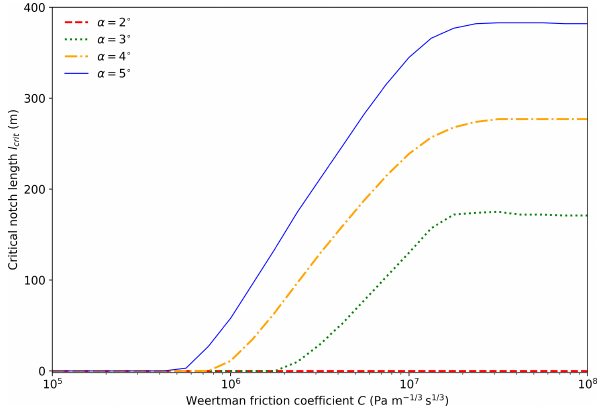
Figure 6. Critical notch length l crit plotted for a range of Weertman coefficients C and surface gradients α .